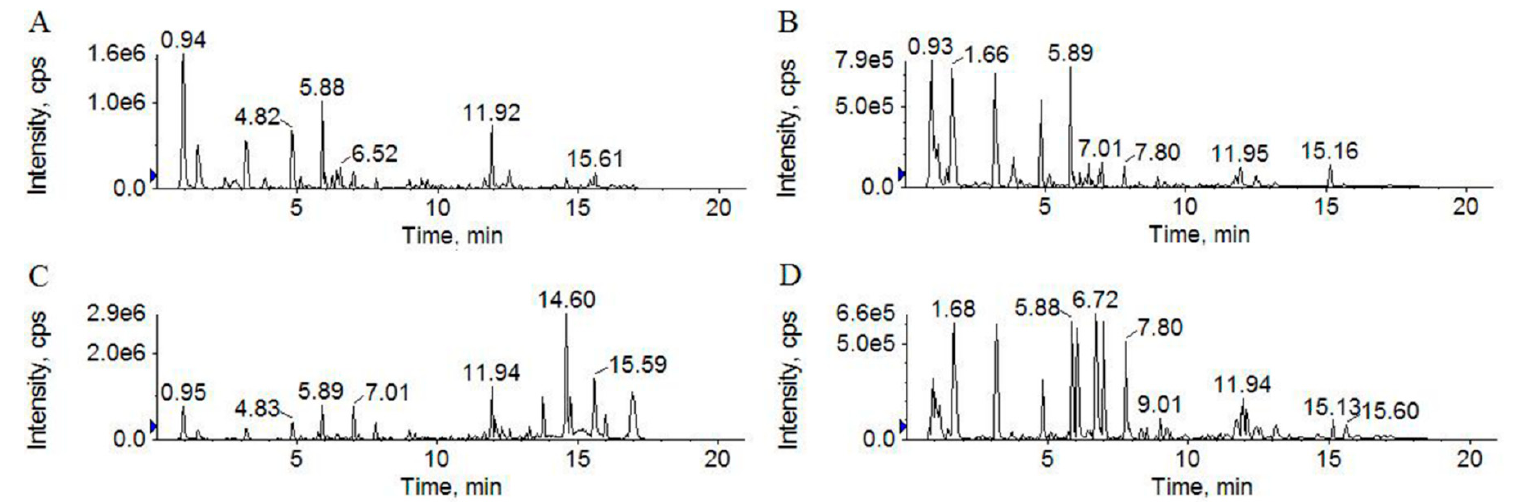
Figure 2. UFLC–TripleTOF MS base peak chromatograms (BPCs) of soybean in positive ( A ) and negative ( B ) ion modes and S8 in positive ( C ) and negative ( D ) ion modes.